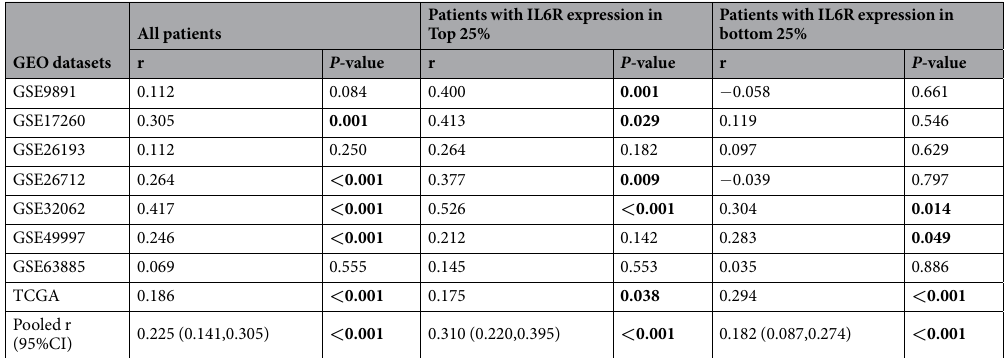
Table 2. The Correlation Coefficient between IL-6 and IL-6ST Depend on the Expression Level of